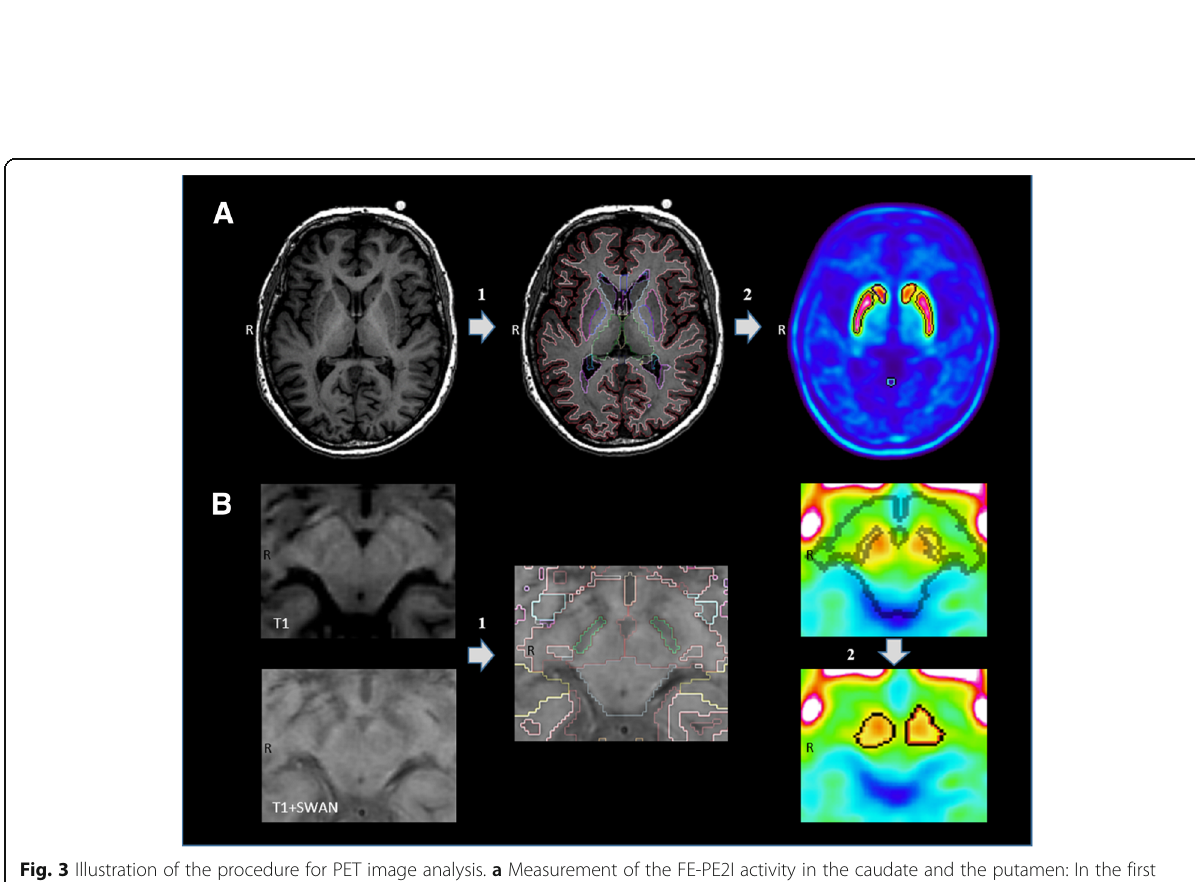
Fig. 2 [ 18 F]FE-PE2I time-activity curves. [ 18 F]FE-PE2I time-activity curves extracted from volume of interests in the native PET image matrix. Left: pooled data acquired in the healthy controls. Right: pooled data acquired in the patients fulfilling criteria for parkinsonian syndrome at inclusion